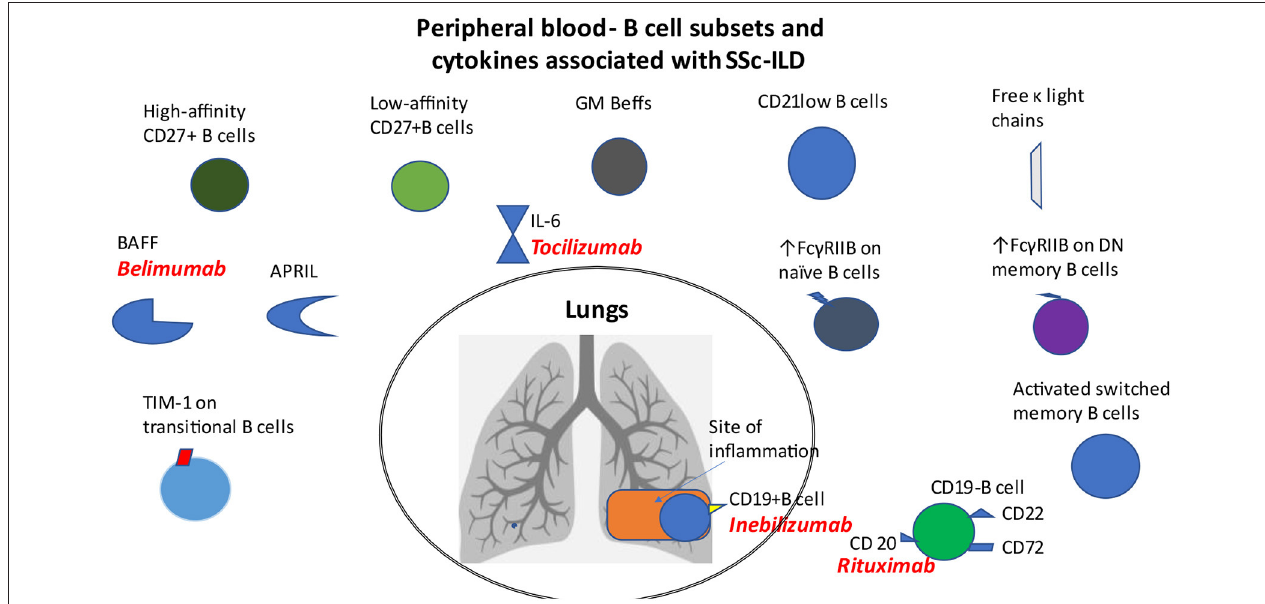
FIGURE 1 | B cell subsets and cytokines in patients with SSc-ILD. Distinct B cell subsets such as CD21 lo , GM-Beffs, activated switched memory B cells, topo I-reactive B cells with high affinity for topo I, increased expression of Fc γ RIIB on naïve B cells and that of TIM-1 on transitional B cells, as well as increased levels of free κ light chains, BAFF and APRIL cytokines are associated with ILD in patients with SSc. CD19 modulates the accumulation of B cells in BAL fluid. Loss of CD22 or CD72 decreased lung